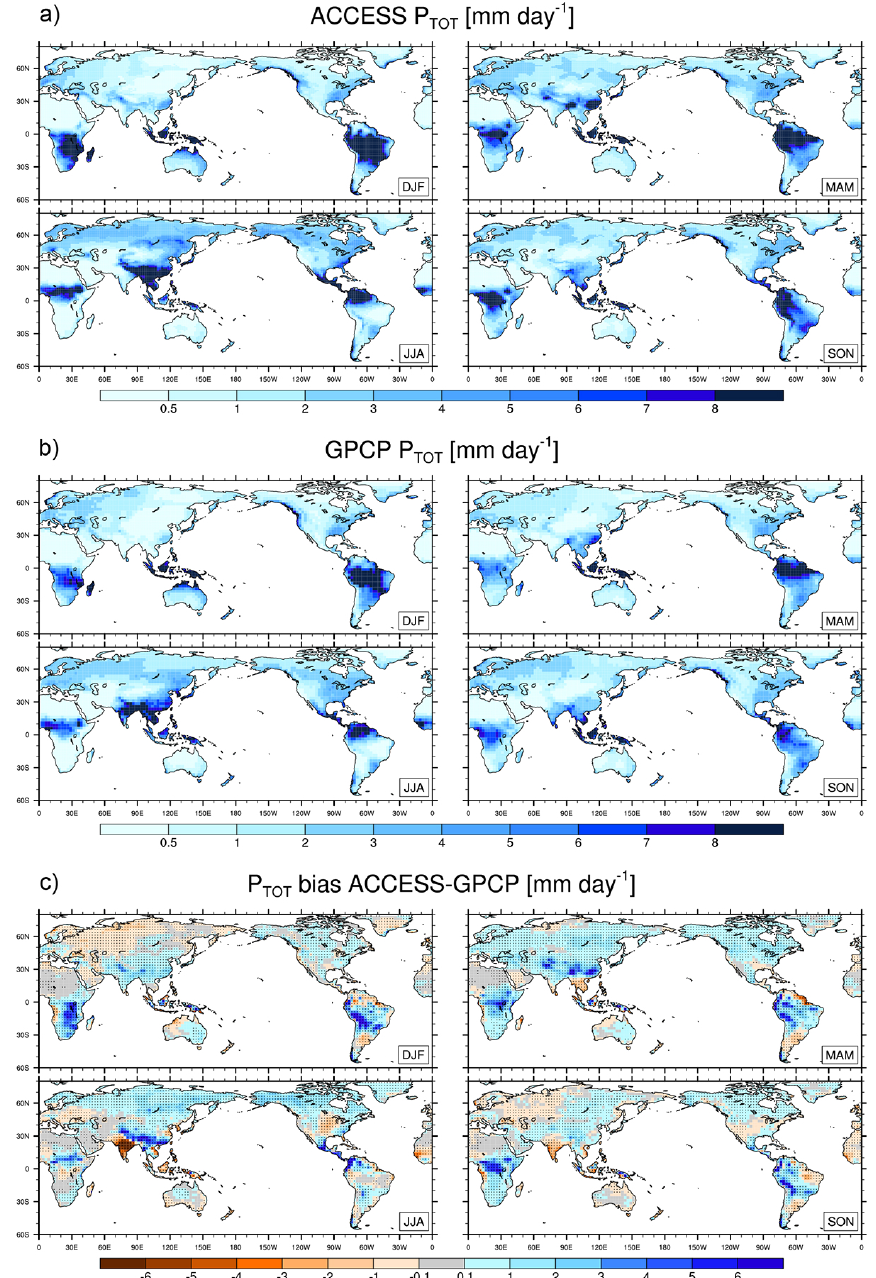
Fig. 3. Total precipitation for ACCESS1.3b (a) , GPCP (b) and bias (c) . The considered time period is the overlapping time period between model run and observations, 1980–2012. Stippling in (c) indicates areas where bias is statistically significant based on the modified t